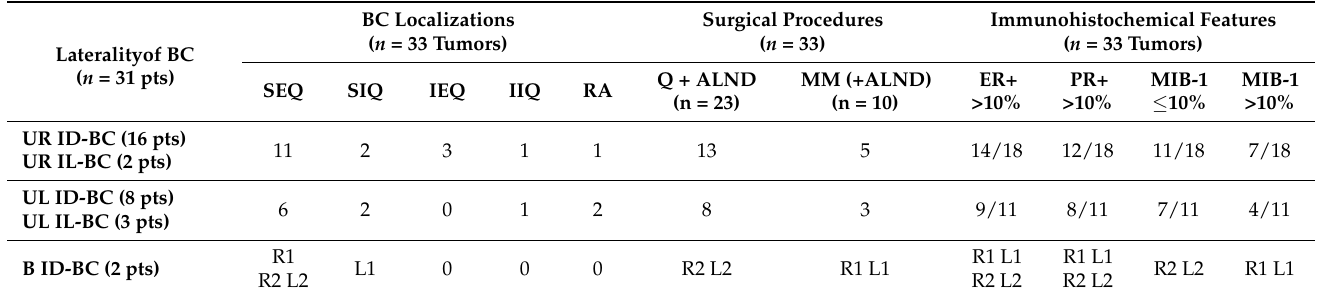
Table 1. Characteristics of BC of the women included in the study